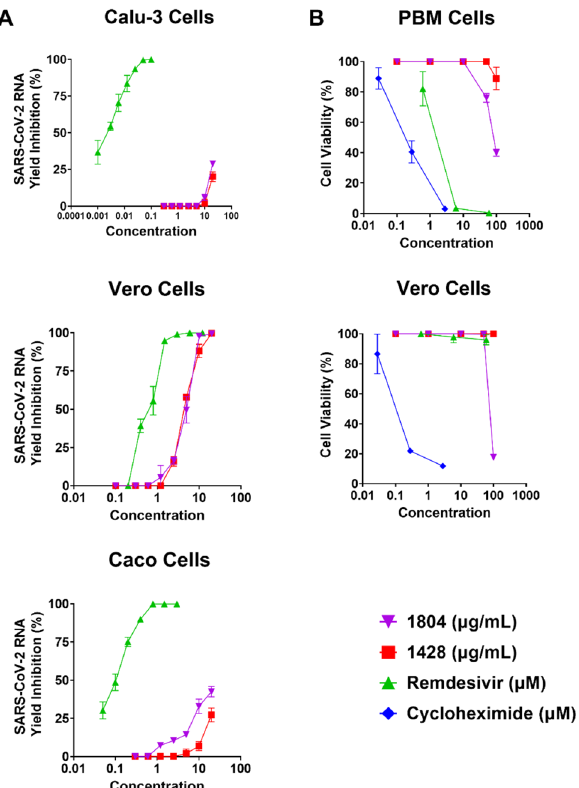
Figure 3. Infectious virus results in different cell lines. ( A ) The antiviral activity of 1804 and 1428 has been further confirmed by virus yield reduction assay using specific qRT-PCR for SARS-CoV-2 to measure the RNA copy number of the virus either 2 days post-treatment (for Vero cells) or 3 days post-treatment (for Calu-3 and Caco-2 cells) in treated-infected cells in a dose response manner. Remdesivir was used as a positive control for both assays. ( B ) Cytotoxicity assays measuring cell proliferation in PBM and Vero cells were performed in parallel to the antiviral assays. Cycloheximide, a known protein synthesis inhibitor, was used as the positive